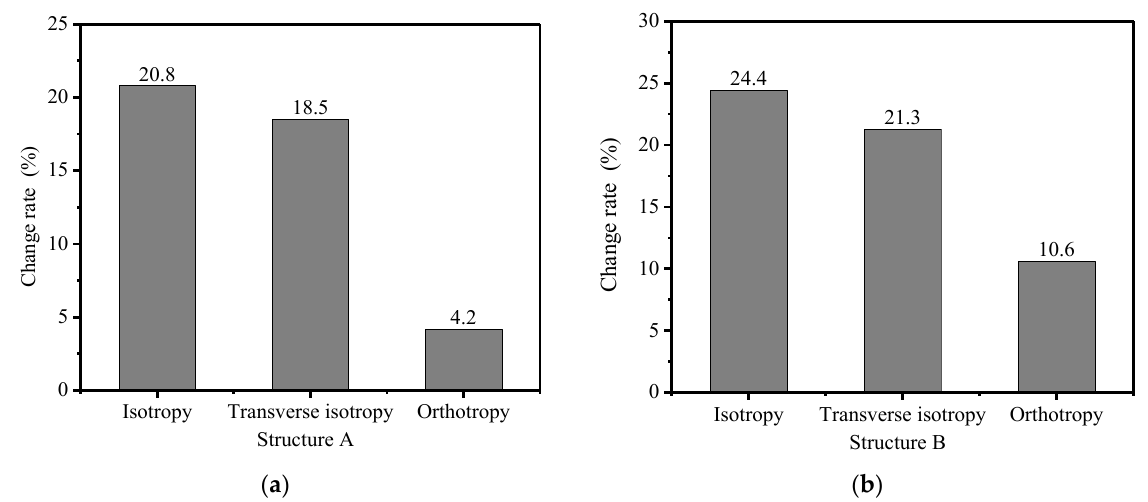
Figure 7. Change rate of the surface defection between the field data and the FE model: ( a ) Structure A. ( b ) Structure B.